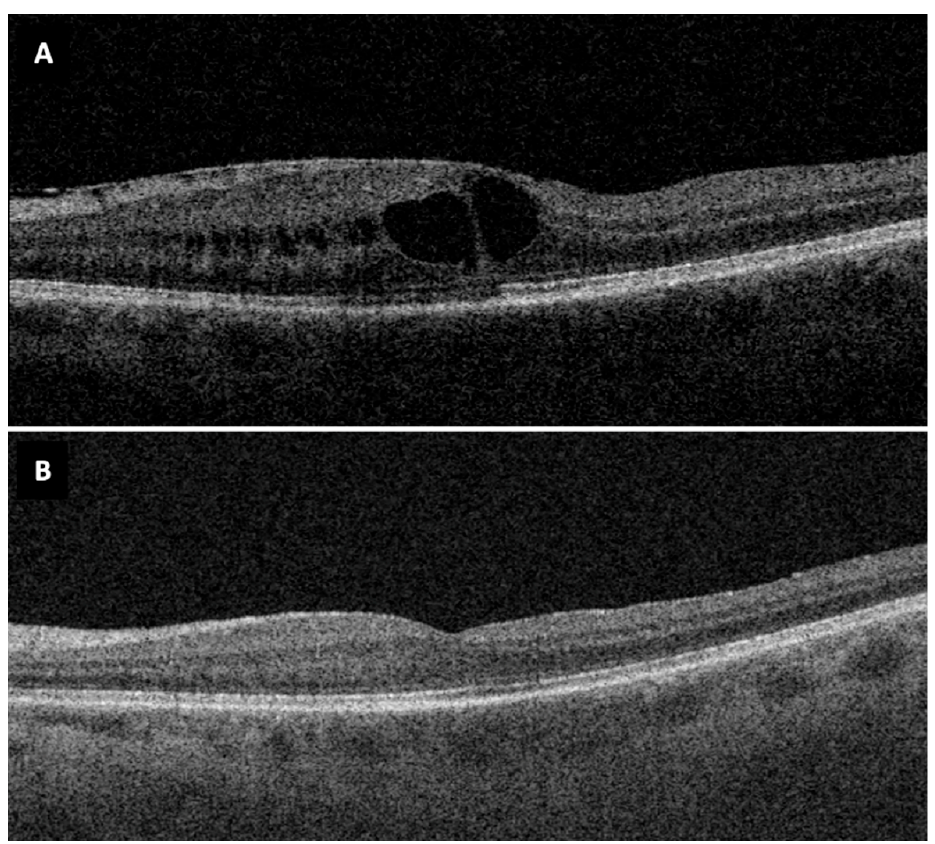
Figure 3. Macular OCT before ( A ) and 6 months after ( B ) vitrectomy and epiretinal membrane peel